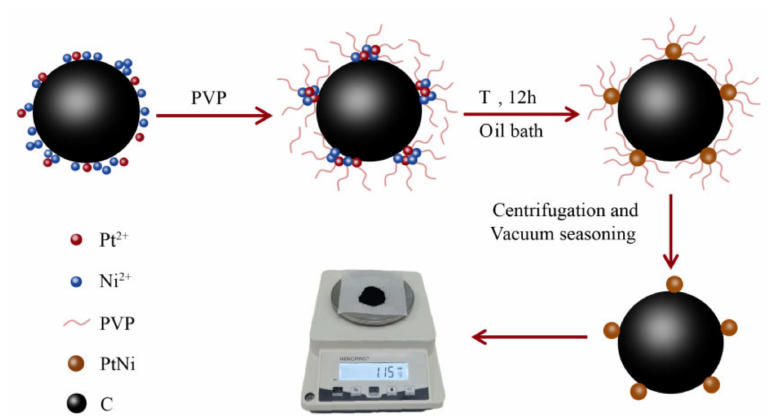
Figure 1. Schematic illustration of the formation of